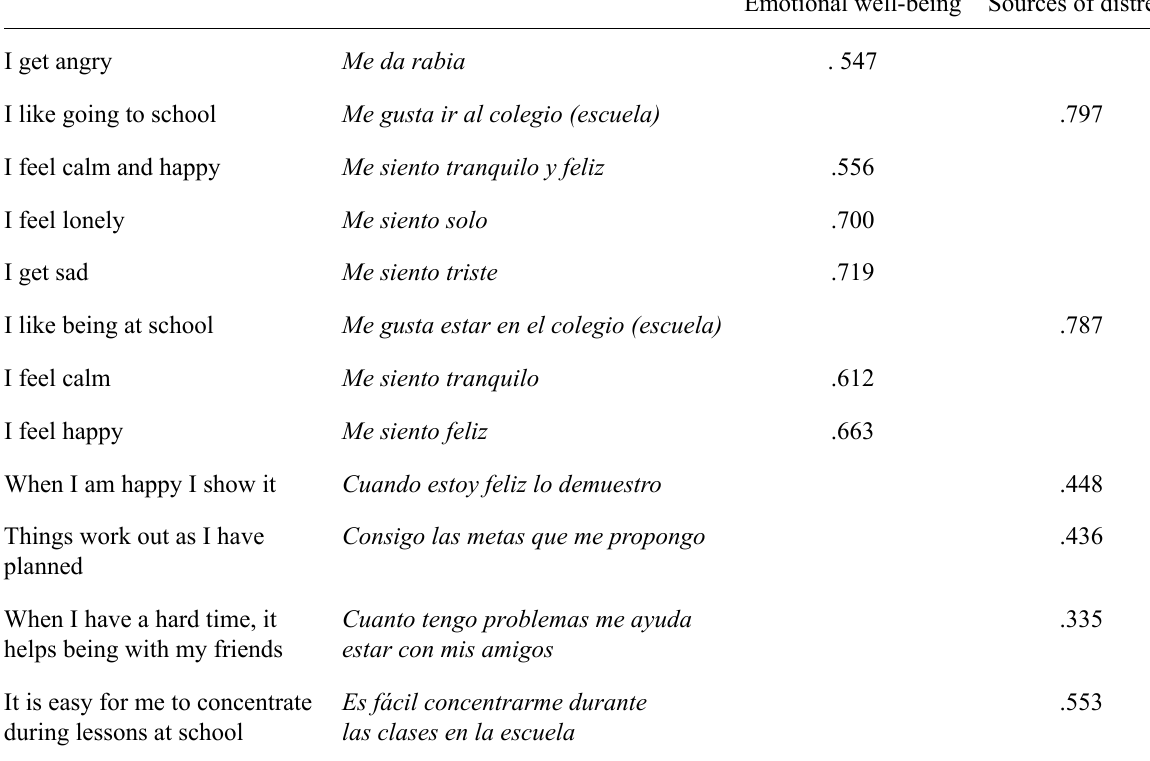
Matrix of Rotated